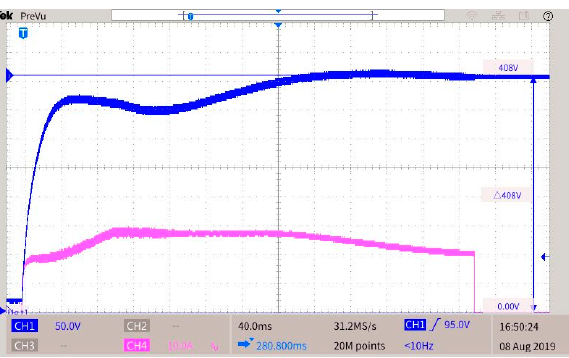
Figure 14. Operation of the double-boost DC-DC converter during pulse operation (DC-link voltage V DC and input current).